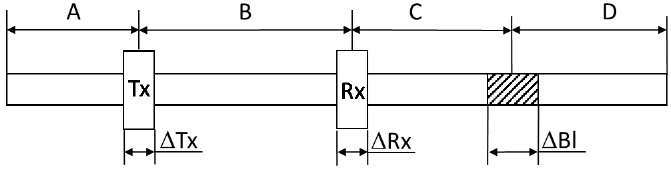
Figure 13. Experimental version of the power source. 1—Input rectifier. 2—Power bridge. 3—Auxiliar buck converter. 4—Control stage.